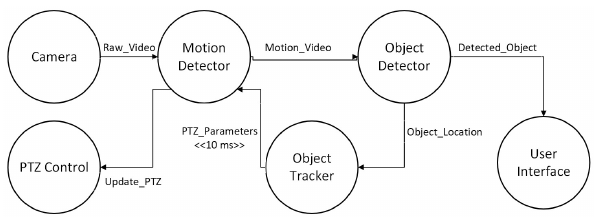
Figure 8. DCNS Application Architecture.